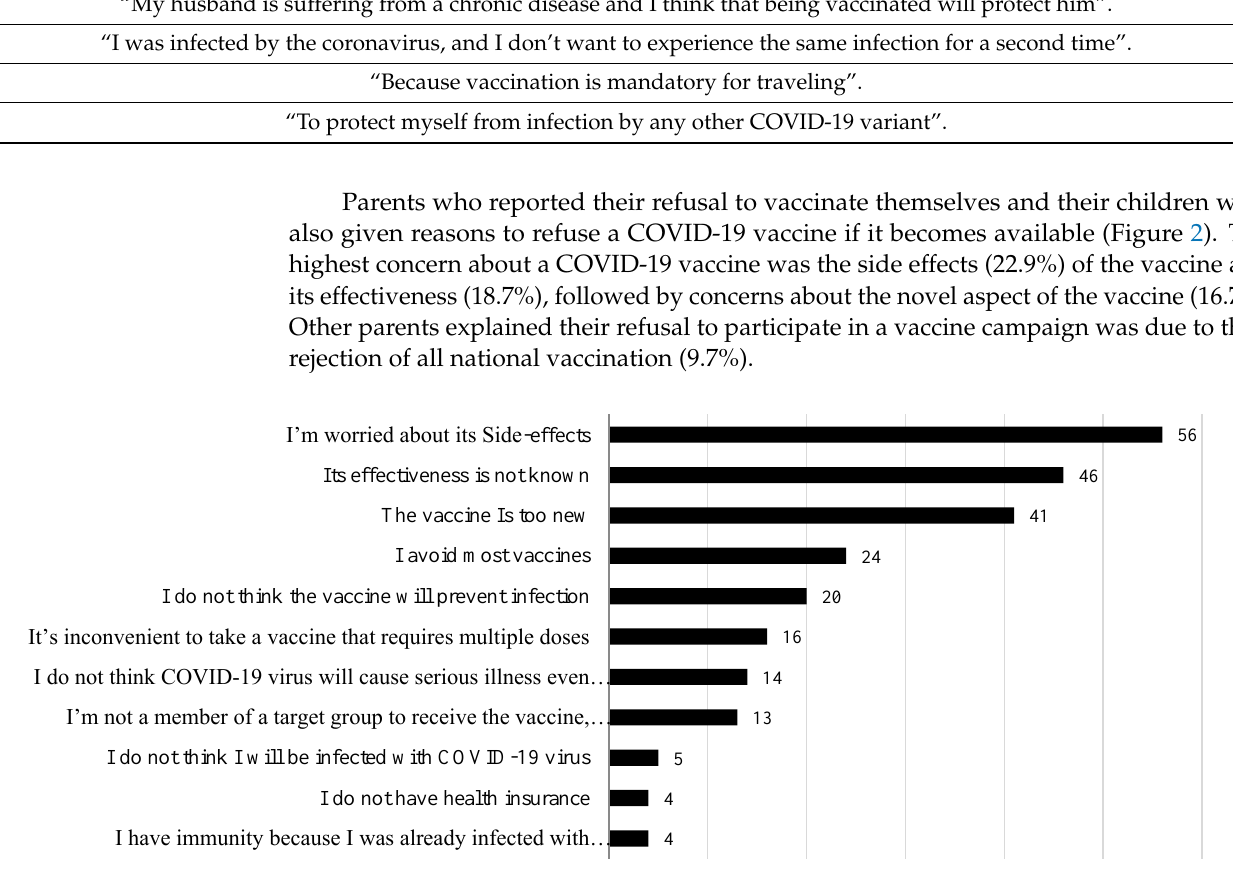
Figure 2. Parental reasons for not accepting to vaccinate themselves or one of their family members with a COVID-19 vaccine .